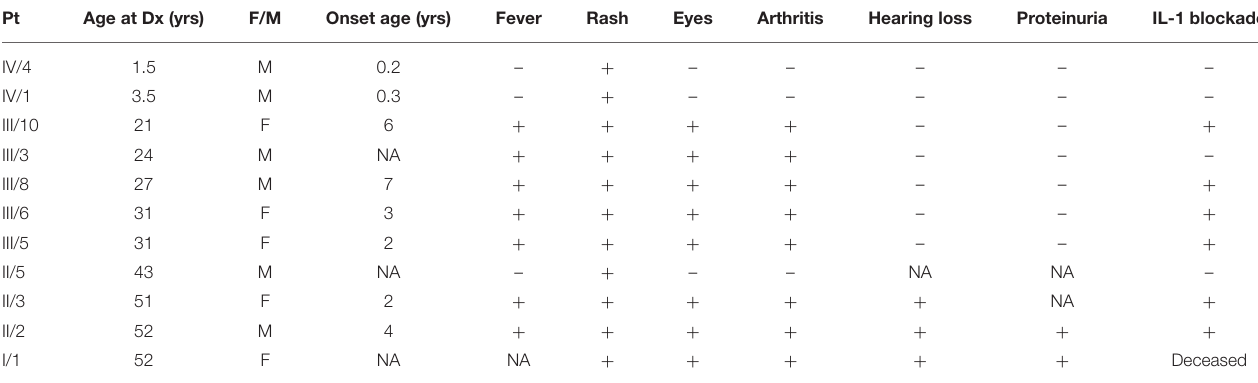
TABLE 1 | Symptoms noticed before the diagnosis.